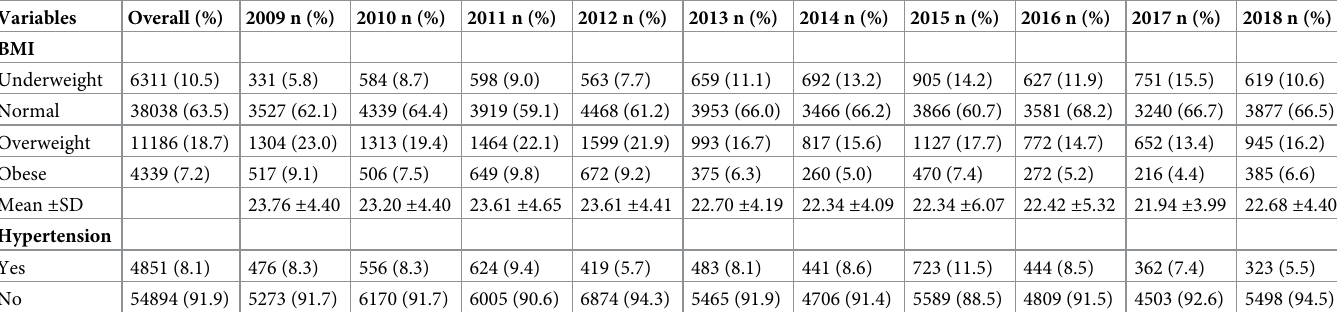
Table 2. BMI and hypertension prevalence at each year of entry of students admitted to the University of Ibadan 2009–2018. Variables